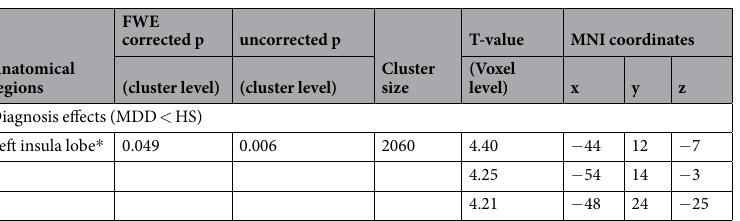
Table 2. Results of VBM analysis. Abbreviations: FWE = family wise error rate; HS = healthy subjects; MDD = Major depression disorders. * See Figure.